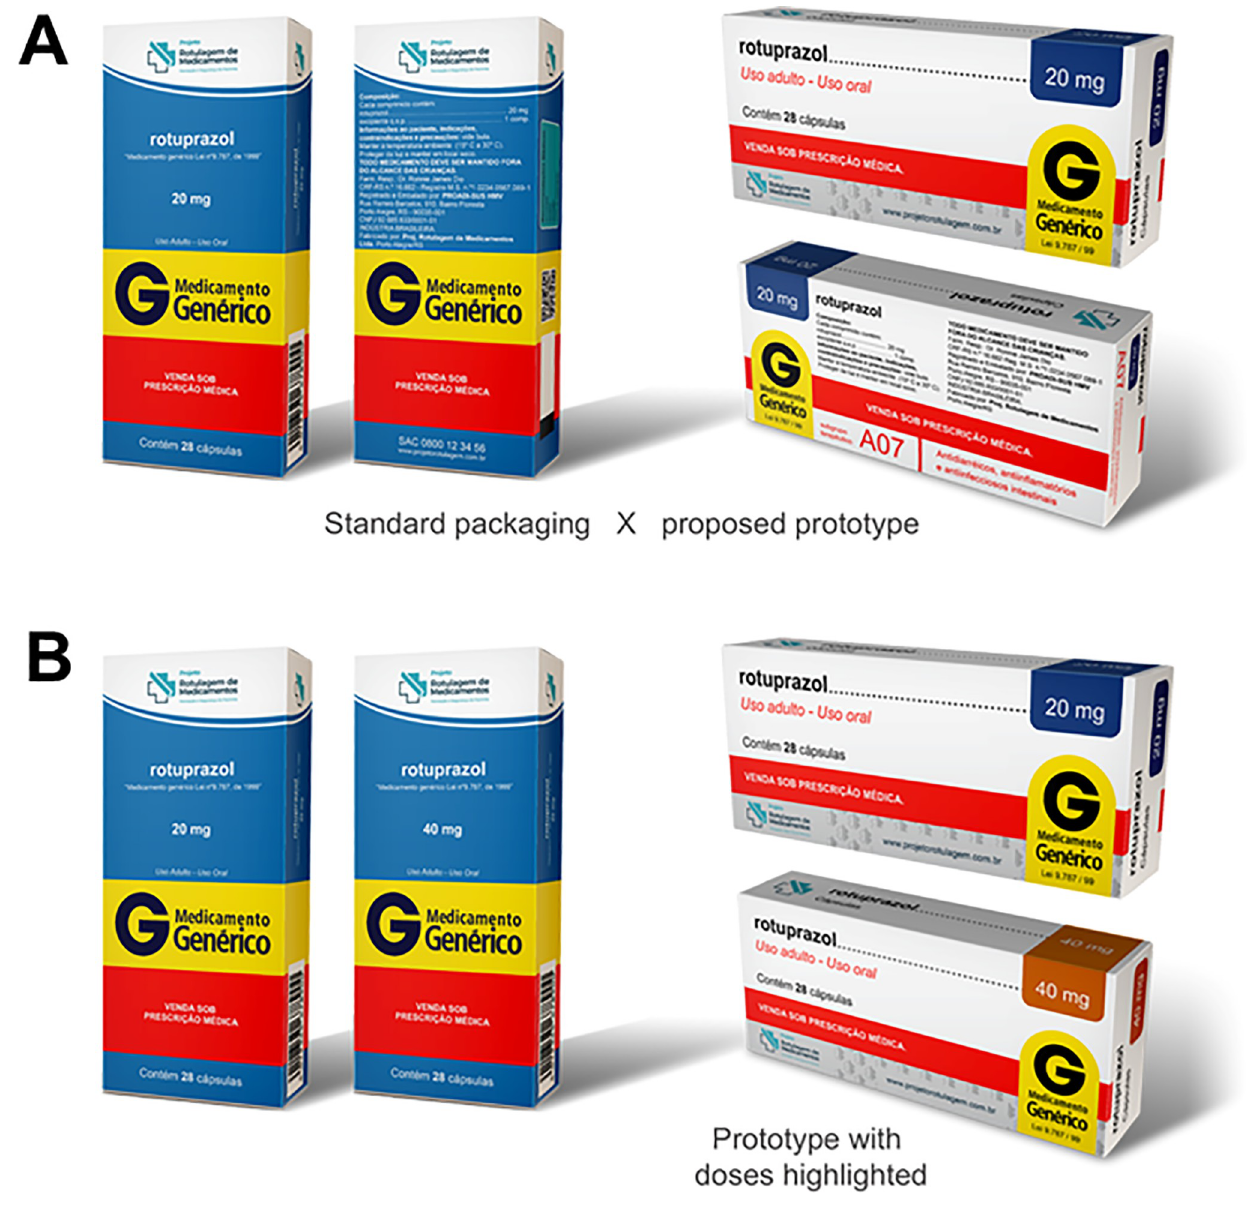
Fig 3. Simulated final proposed designs. A) Standard packaging × proposed prototype. B) Prototype with doses